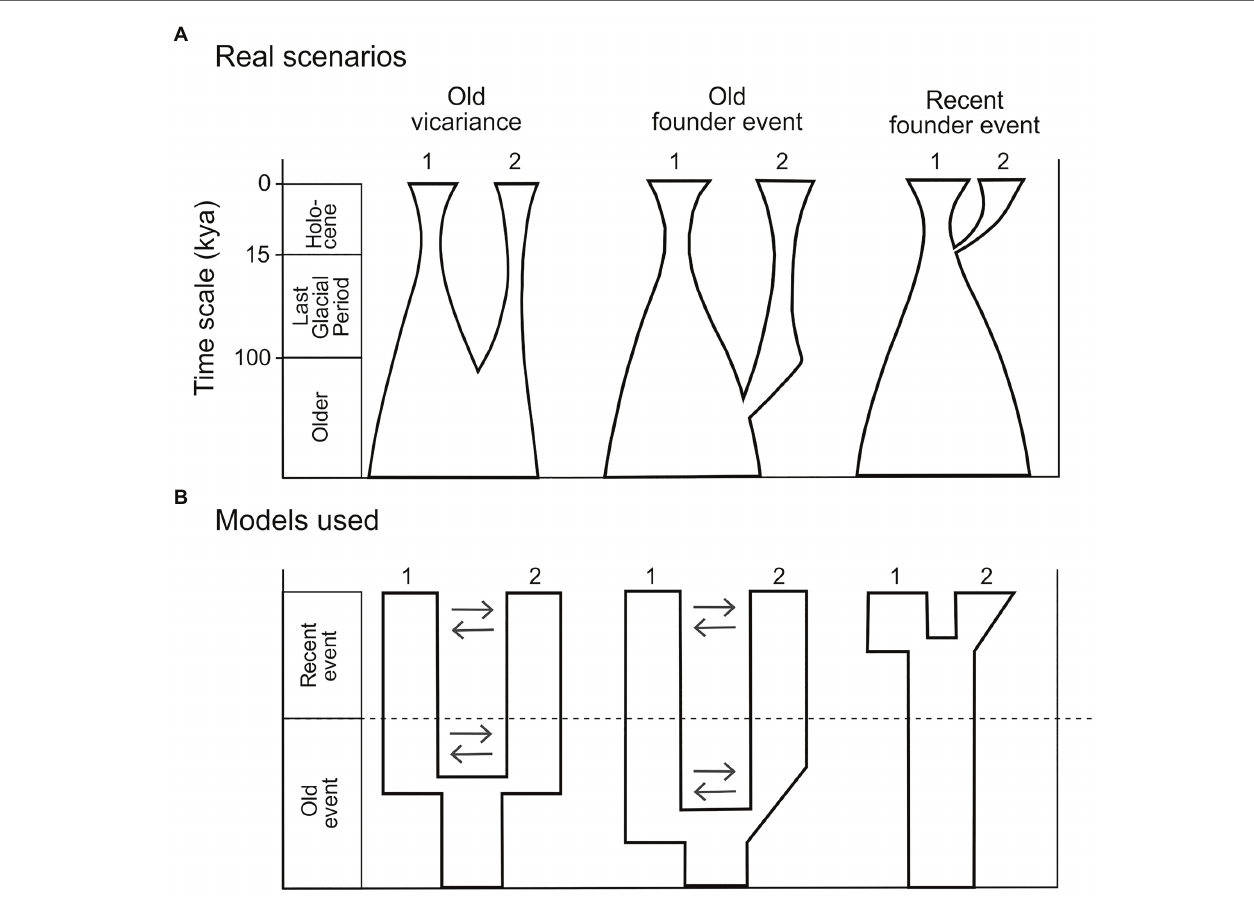
FIGURE 2 | (A) Scenarios explaining the disjunct distribution of current H. niger populations. In the left and middle pane, pre-glacial vicariance or a pre-glacial founder event led to the split of the ancestral population into the current populations 1 and 2. In the right pane, a post-glacial founder event gave rise to population 2 from the ancestral population 1. See detailed description in the Introduction section. (B) Summary of models simplifying particular scenarios in (A) , tested using demographic models in dadi. All models tested are shown and described in Supplementary Figure 1 . Numbers 1 and 2 refer to current populations (i.e., genetic groups defined based on STRUCTURE analysis); gene flow is indicated by